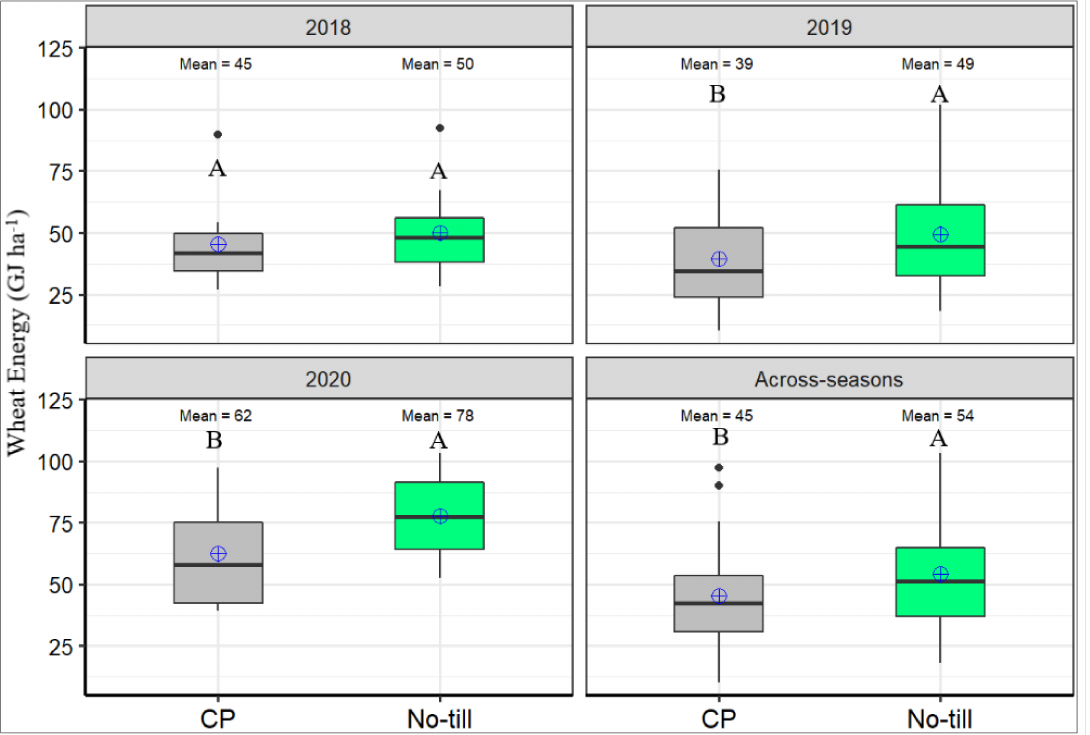
Figure 7. Energy contributions from conventional practice and NT treatments under wheat cropping system in 2018, 2019, 2020 and across the growing seasons. Means with different letters (A, B) in the same season are significantly different at p <